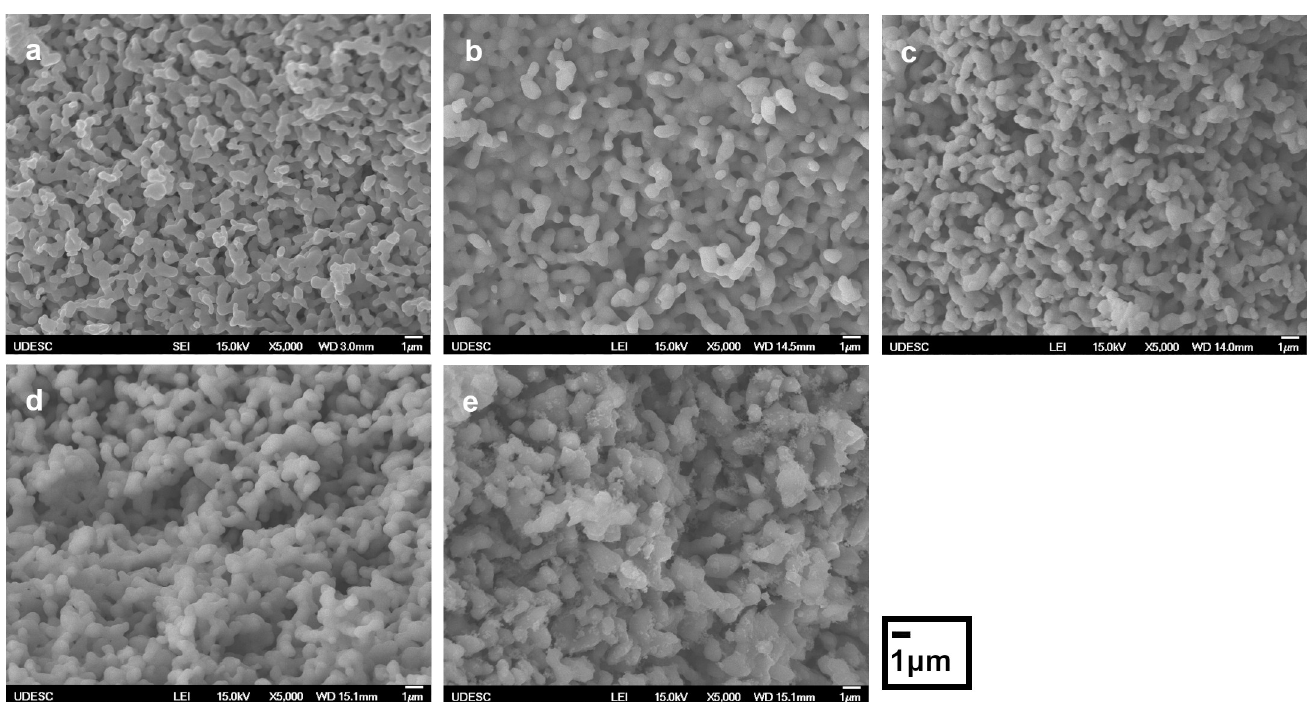
Fig 1. The initial microstructure of the biomaterials. Scanning electron microscopy analysis of (a) hydroxyapatite (HA); (b); β -tricalcium phosphate ( β -TCP); (c) biphasic calcium phosphate (BCP); (d) β -TCP/MgO nanocomposite; (e) β -TCP/SiO 2 nanocomposite.